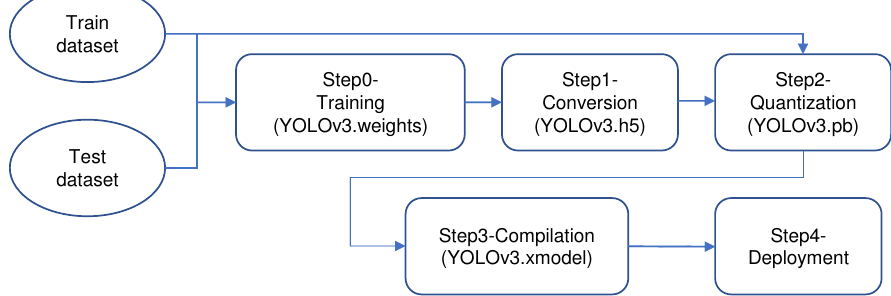
Figure 4. Flow of deploying the YOLOv3 model on the ZCU102 evaluation